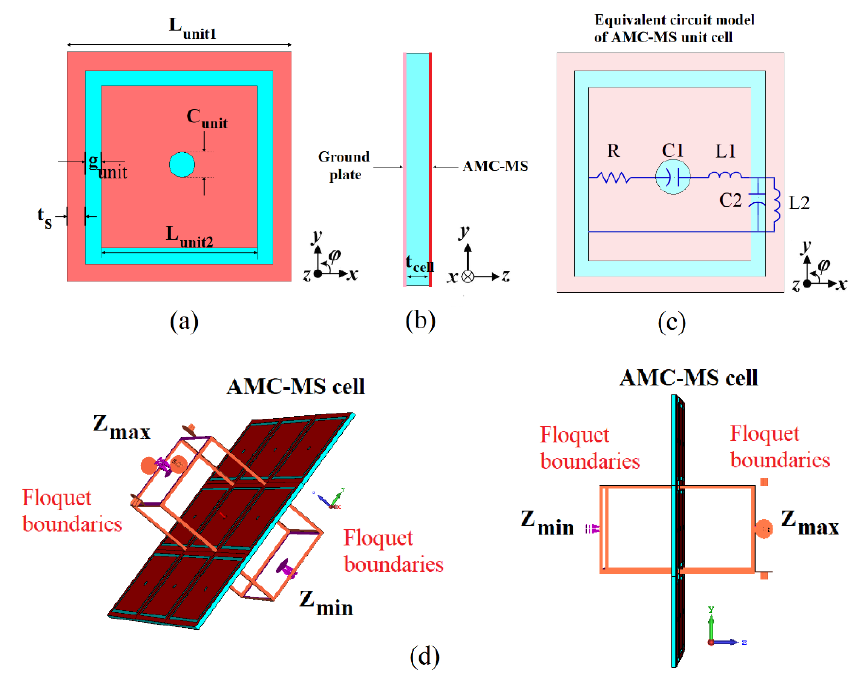
Figure 4. ( a ) Checkerboard-hole-injected unit cell: top view, ( b ) side view; ( c ) equivalent circuit model; and ( d ) floquent boundary arrangement of the unit cell with excitation ports Z max and Z min